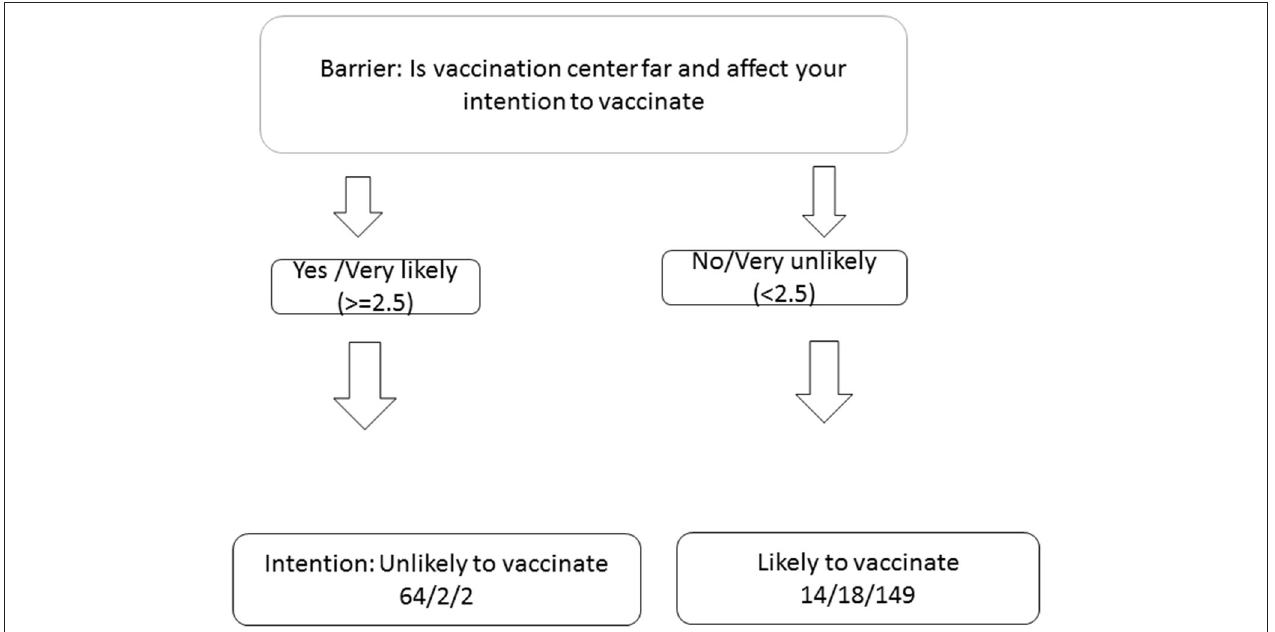
FIGURE 1 | Classification tree for preventive behavior. Numbers in bracket indicate those stating that they will not vaccinate, maybe vaccinate and will vaccinate their dogs respectively. For instance, about unlikely to vaccinate: 82% (64/78), somehow likely to vaccinate 10% (2/20) and likely to vaccinate 1% (2/151) of dog owners who were categorized as unlikely, somewhat likely and likely to vaccinate respectively indicated agreement ( ≥ 2.5) to the question: “If I want to vaccinate my dog, vaccination centers being located far from my house reduce the chance for me to get my dog vaccinated.” Similarly, 18% (14/78), 90% (18/20), and 99% (149/151) of dog owners who were categorized as unlikely, somewhat likely and likely to vaccinate respectively responded strongly disagree or disagree to the question.